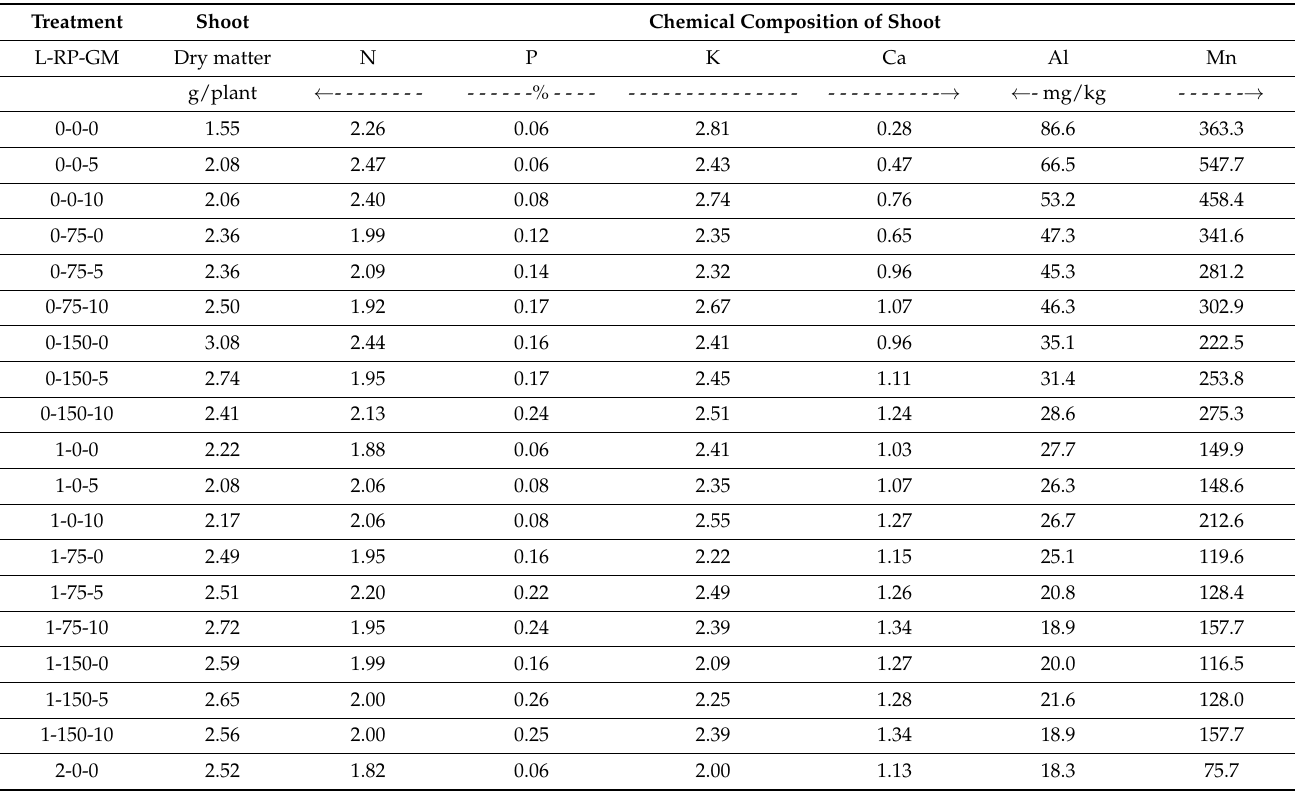
Table 5. Soybean dry matter and its chemical composition as affected by lime, rock phosphate, and cowpea green manure applications to an acid Oxisol of